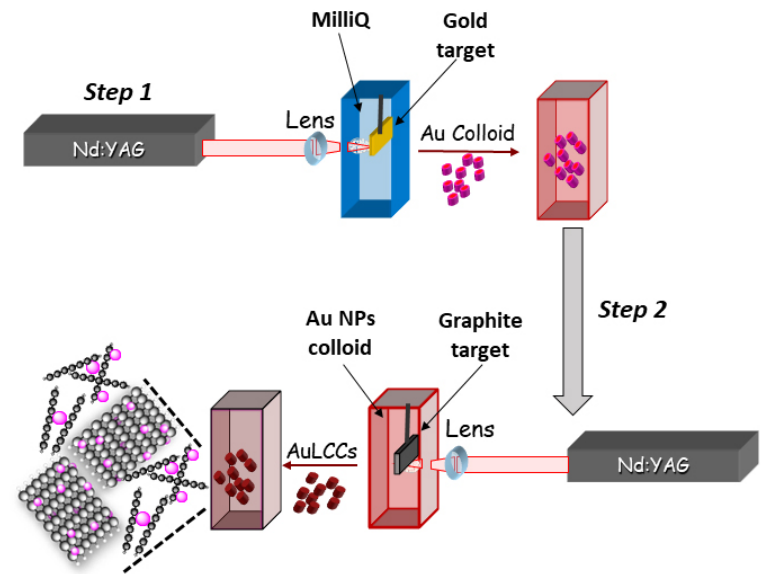
Figure 1. Steps followed during PLAL processes and representative scheme of the so synthesized Au@LCCs hybrid